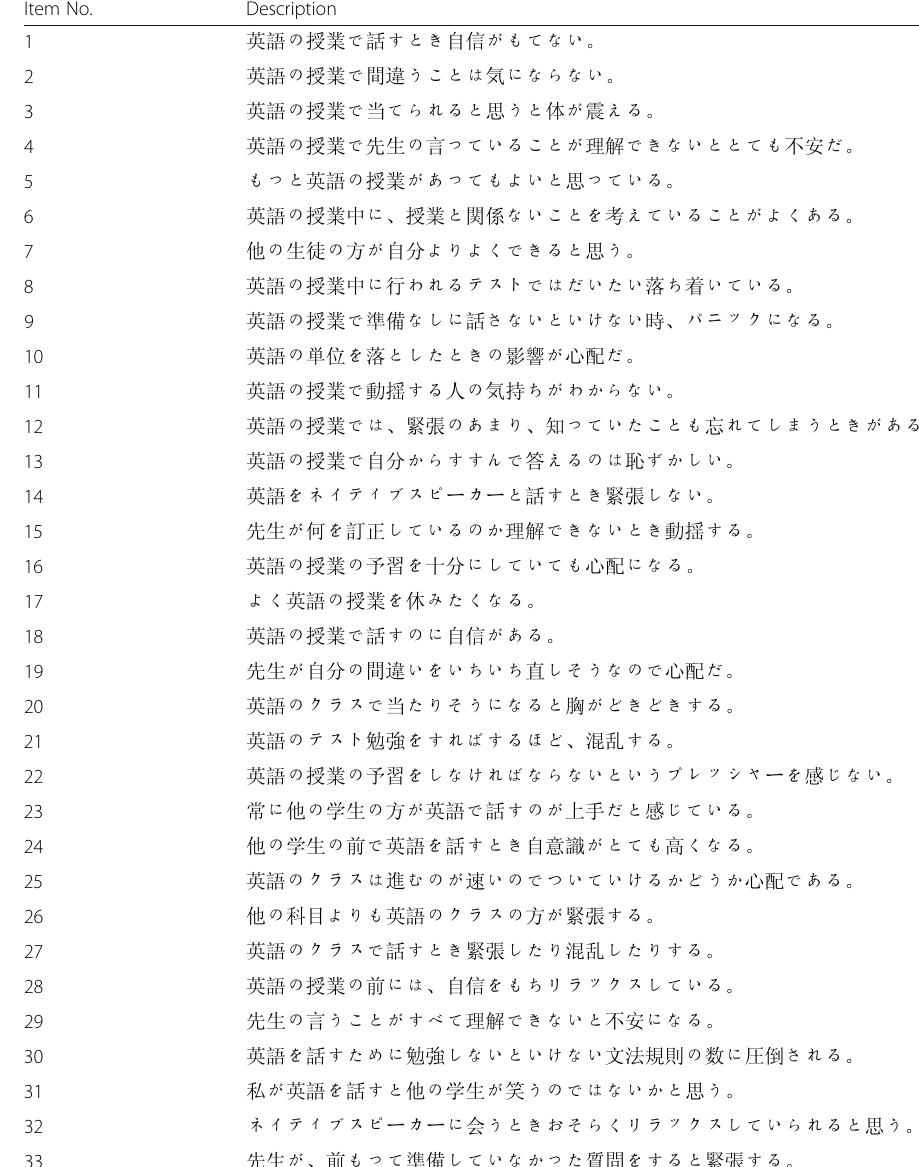
Table 9 The Japanese version of the Foreign Language Classroom Anxiety Scale (Yashima et al. 2009) Item